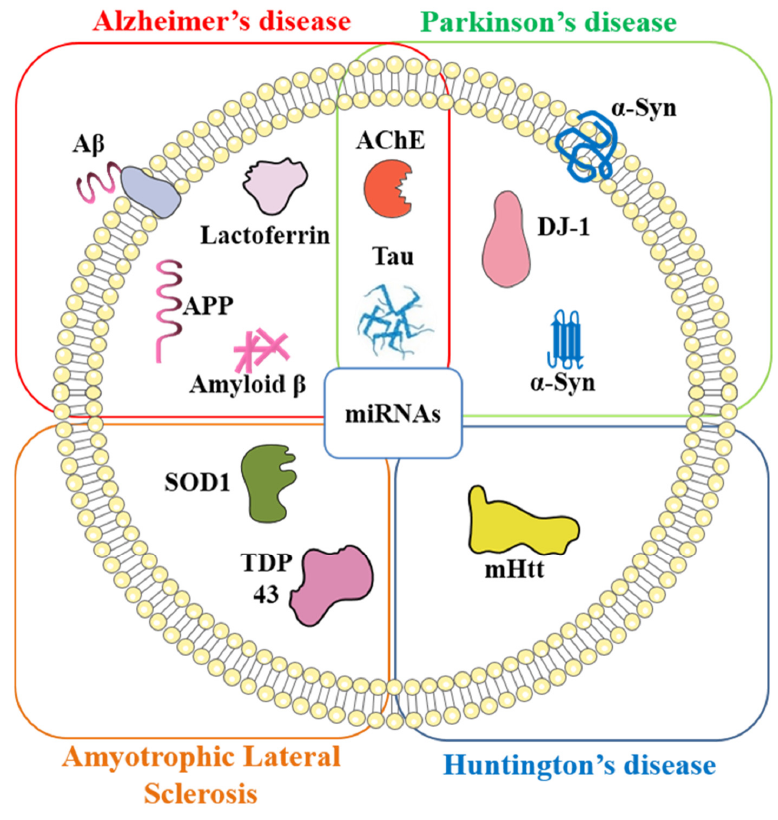
Figure 1. Schematic representation of key exosomal biomarkers in neurodegenerative diseases. Amyloid-beta (A β ), amyloid precursor protein (APP), acetylcholinesterase (AChE), alpha-synuclein ( α -syn), super-oxide dismutase 1 (SOD1), tar-DNA binding protein-43 (TDP-43), mutant huntingtin protein (mHtt), and micro RNAs (miRNAs).